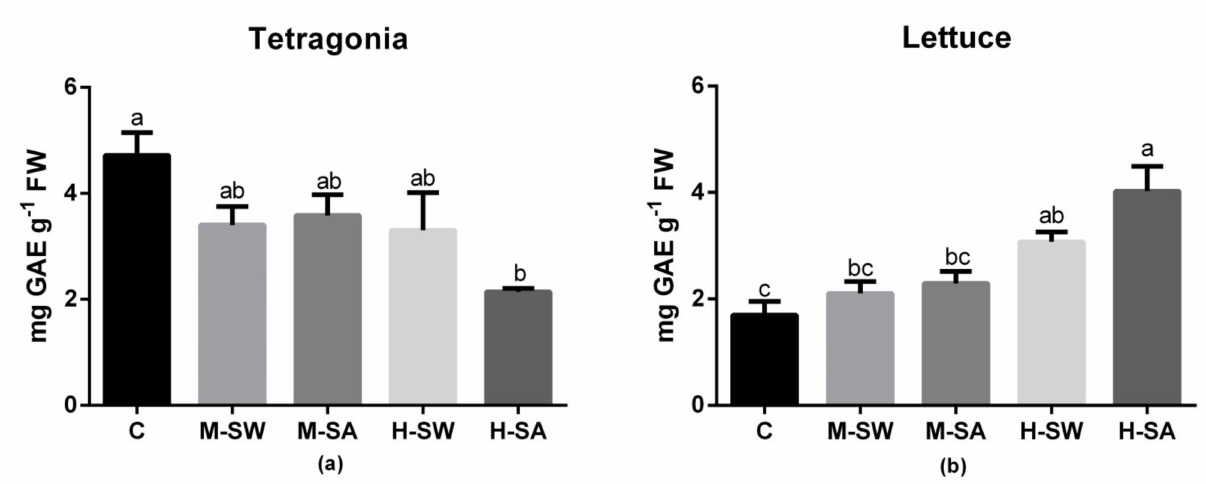
Figure 5. Phenolic concentration in the edible leaves of Tetragonia ( a ) and lettuce ( b ). Values are means ( n = 4) ± SEM measured at the end of the crop cycles. Different letters indicate significant differences at p < 0.05 (Tukey’s test).